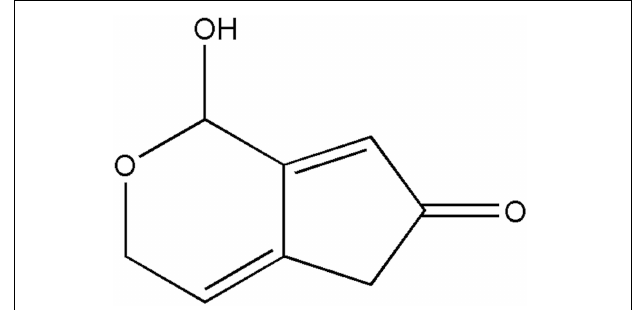
FIGURE 1 | Molecular structure of